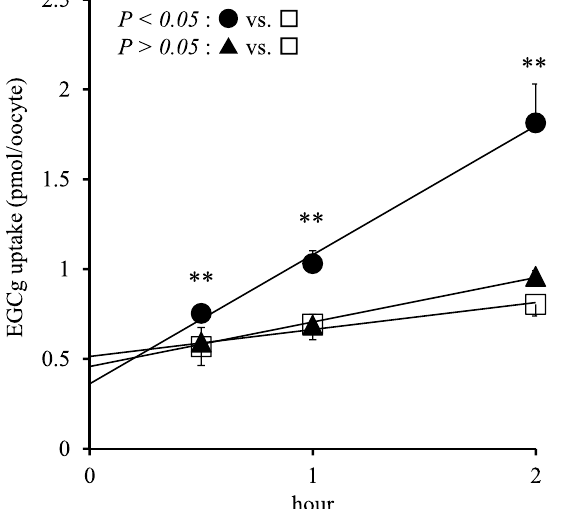
Figure 3. Time-course data of epigallocatechin gallate (EGCg) uptake by Xenopus laevis oocytes microinjected with diastrophic dysplasia sulfate transporter (DTDST) cRNA ( ● ), zinc transporter 14 (ZIP14) cRNA ( ▲ ) or water ( □ ) (n = 6–8/group) incubated with 500 μ M EGCg. Linear approximation was performed and the line is shown. Two-factor repeated measures ANOVA was used to evaluate the group-by-time interaction and the P values are shown in the upper-left of the panel. Data are presented as mean ± SD. Significant differences as determined by Student’s t -test are indicated by ** ( P <